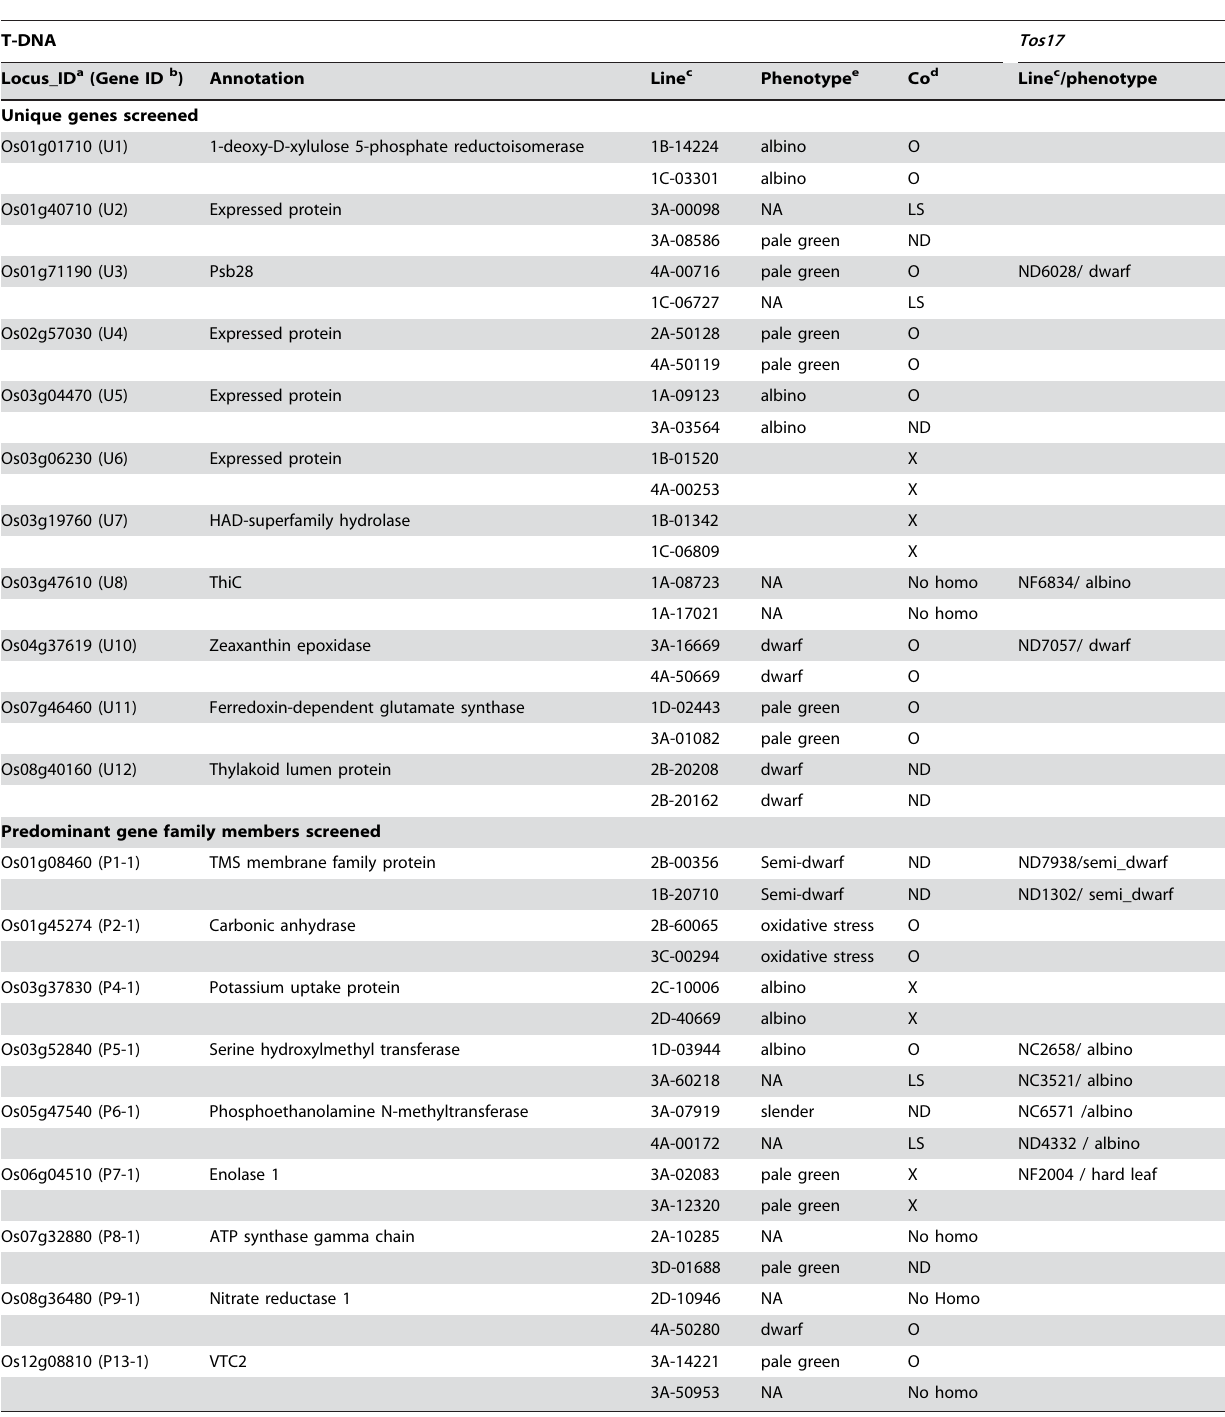
Table 2. Summary of Screen for Phenotypes Associated with 20 Candidate Genes Showing at least 8-Fold Induction in the